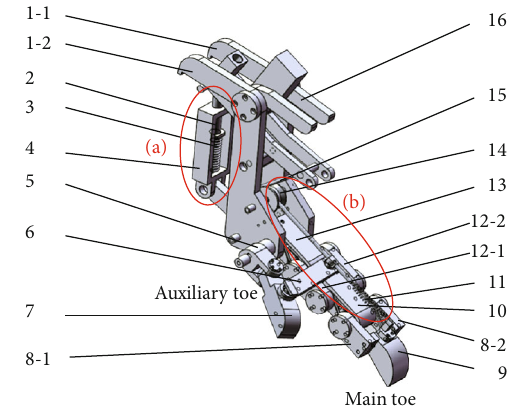
Figure 2: Bionic mechanical foot structure: (1) support plate, (2) stud, (3) fl exion spring, (4) fl exion frame, (5) the fi rst phalanx of the auxiliary toe, (6) imitated ligament structure, (7) the second phalanx of the auxiliary toe, (8) the fourth phalanx of the main toe, (9) toenail structure, (10) the third phalanx of the main toe, (11) extension spring, (12) the second phalanx of the main toe, (13) the fi rst phalanx of the main toe, (14) pulley, (15) wire rope, and (16) lever.